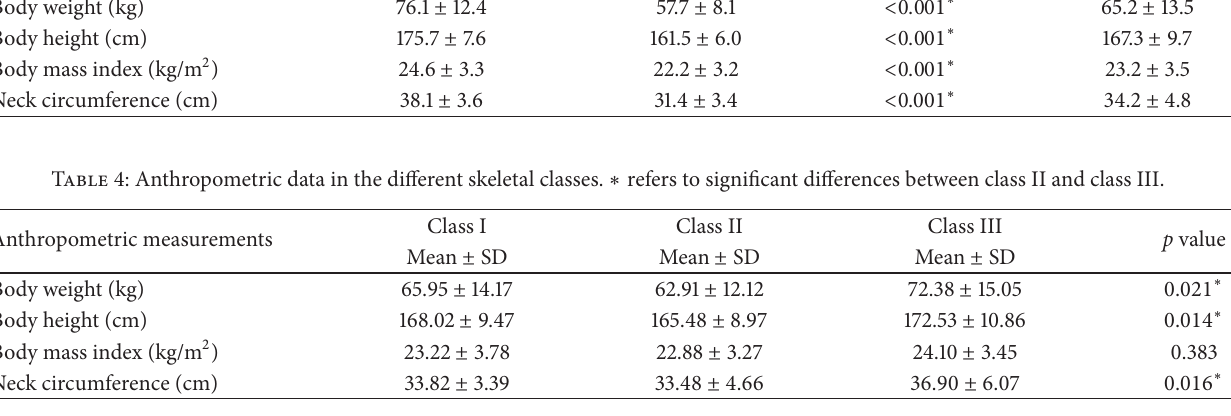
Table 3: Anthropometric data in 117 young adult healthy Lebanese subjects. ∗ refers to significant differences between males and females. Anthropometric measurements